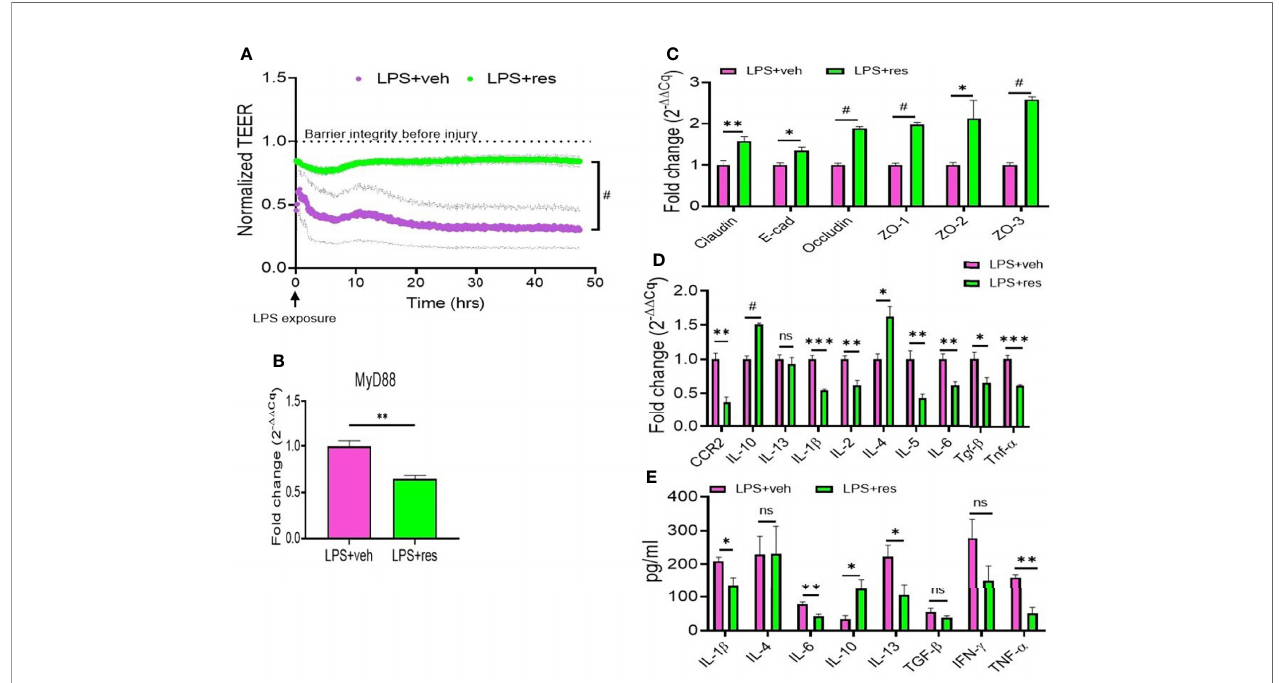
FIGURE 5 | Effect of RES on the integrity and functions of mouse epithelial cells. MLE-15 mouse epithelial cell layer was exposed to LPS and treated with either RES or VEH. (A) Transepithelial electrical resistance (TEER) measurement system was used in the analysis of the integrity and permeability of cultured MLE-15 mouse epithelial cell layer exposed to LPS and treated with either RES or VEH. RT-qPCR was used to detect the gene expression in the LPS-treated MLE-15 cells incubated with RES or VEH. The genes studied included: (B) MyD88, (C) Tight junction proteins (claudin, E-Cad, occuludin, ZO-1, ZO-2 and ZO-3), (D) Cytokines and chemokines (CCR2, IL-10, IL-13, IL-1 b , IL-2, IL-4, IL-4, IL-6, TGF- b and TNF- a ). (E) ELISA was used in the measurement of cytokines (IL-1 b , IL-4, IL-6, IL-10, IL-13, TGF- b , IFN- g and TNF- a ) in the supernatants of MLE-15 cell cultures in the presence of LPS and RES or VEH (E) . ns, not signi fi cant, *p<0.05, **p<0.01, ***p<0.001, #